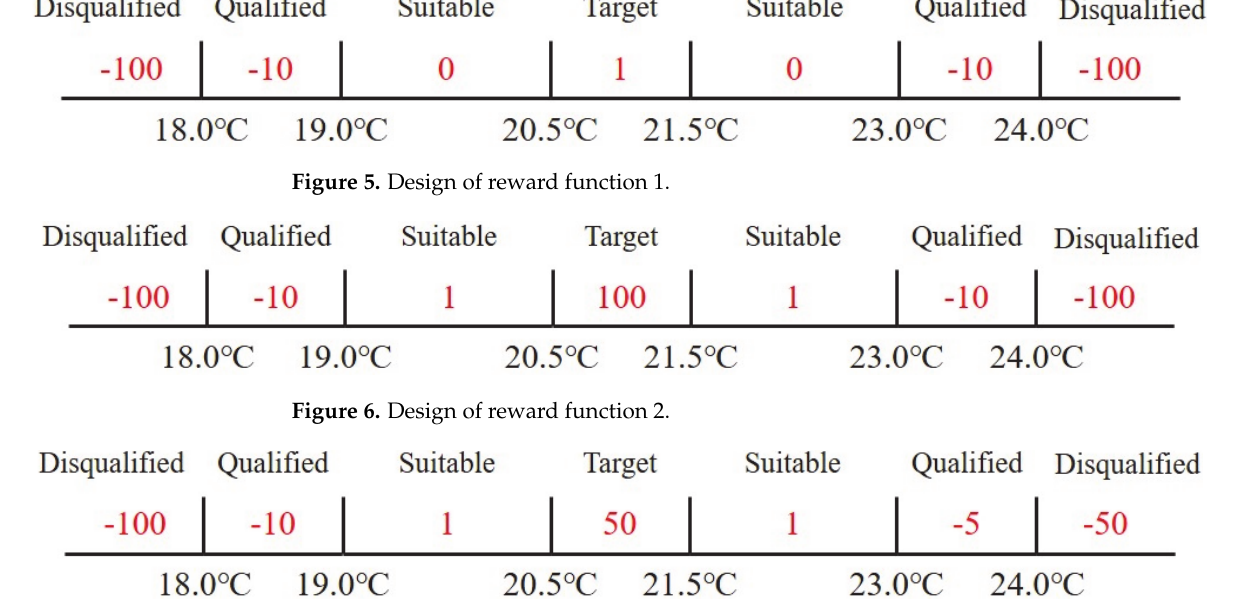
Figure 5. Design of reward function 1.